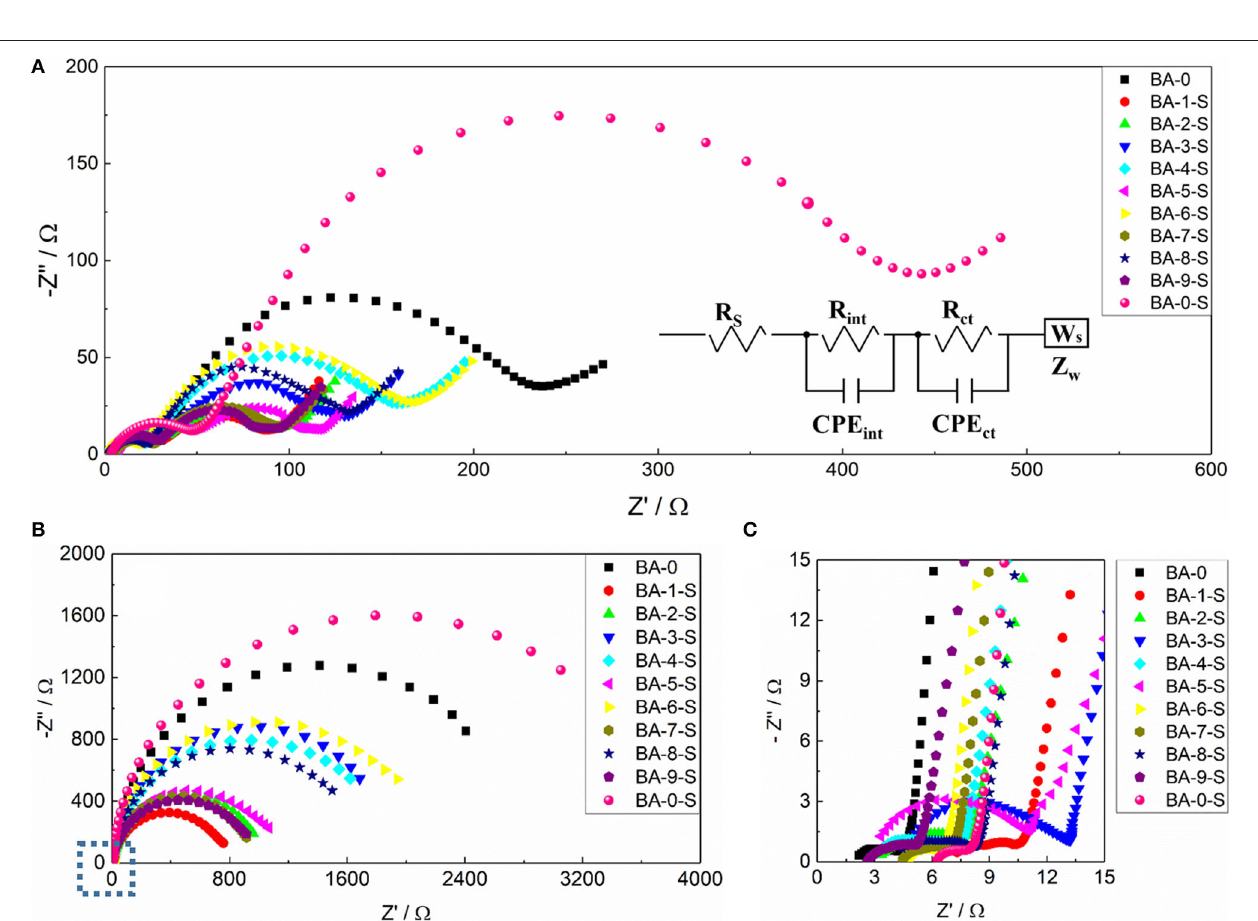
FIGURE 6 | Nyquist plots of all samples after (A) 1st and (B) 100th cycles at 1 C/1C rate and (C) the magnified area of marked area in (B) . The insert in (A) is the equivalent circuit model of all samples.